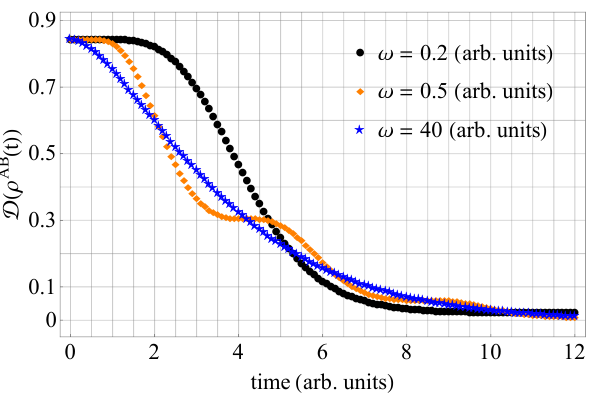
Figure 12. Plots present the Bures distance, D ( ρ AB ( t )) , for three values of ω